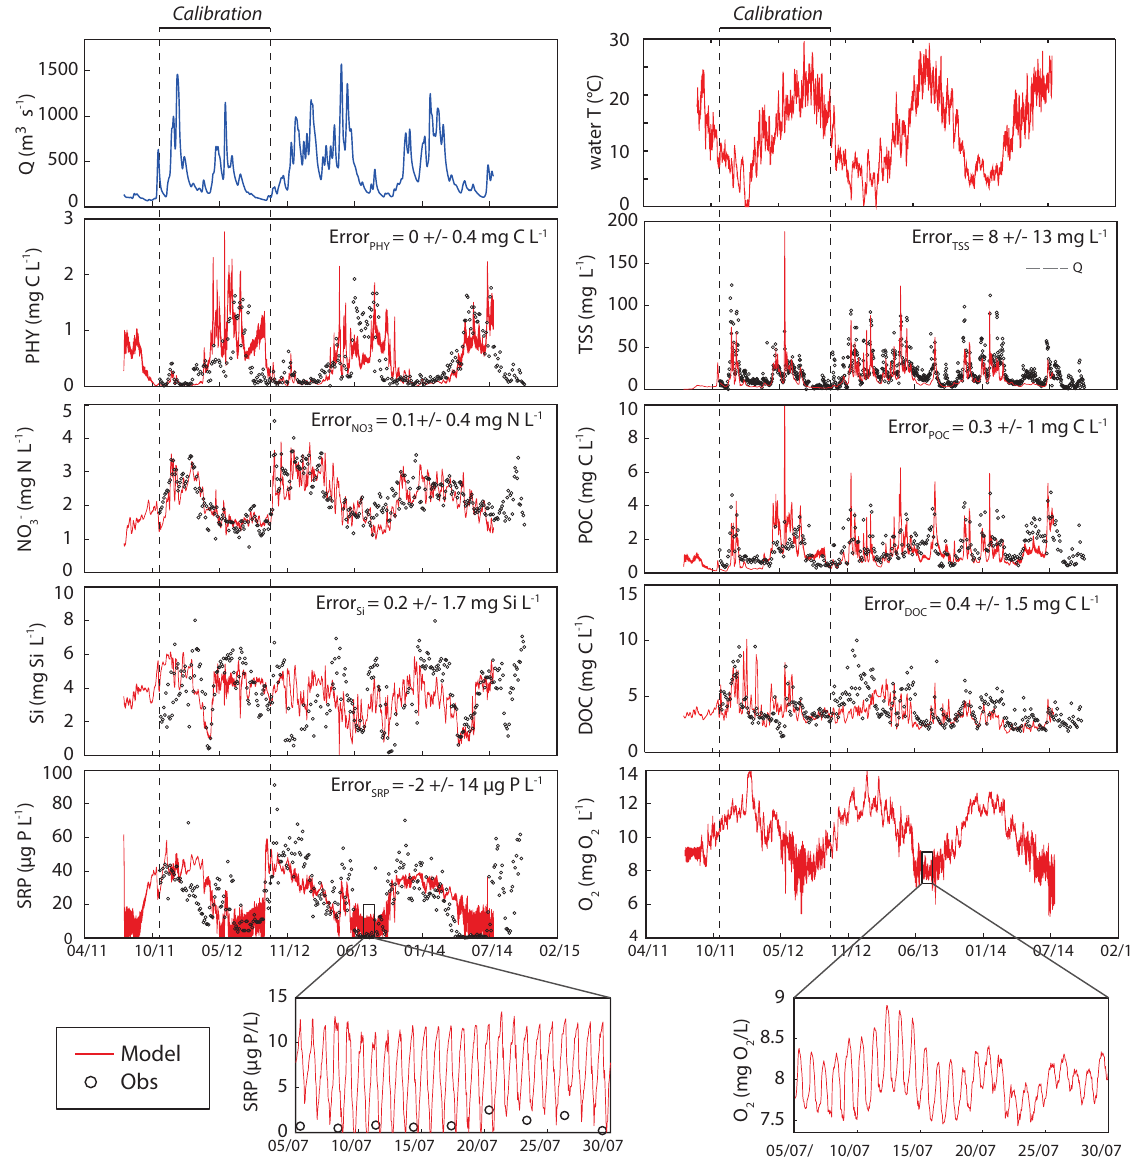
Figure 4. Results at station S2 after calibration for the main variables in the model: discharge ( Q ), phytoplankton (PHY), nitrate (NO − dissolved silica (Si), soluble reactive phosphorus (SRP), water temperature, total suspended solids (TSSs), particulate organic carbon (POC), dissolved organic carbon (DOC), dissolved oxygen (O 2 ). Last row zooms in on SRP and O 2 concentrations in July 2013 to show simulated diel